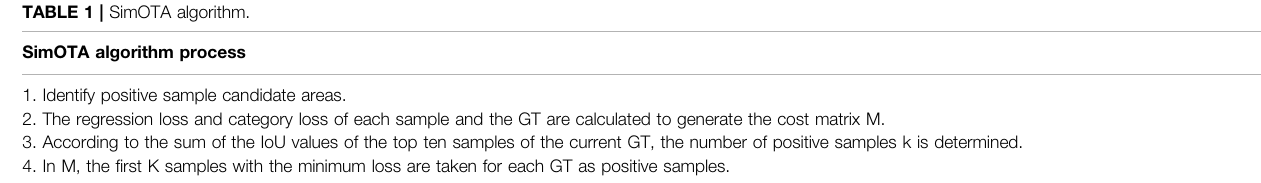
TABLE 1 | SimOTA algorithm. SimOTA algorithm